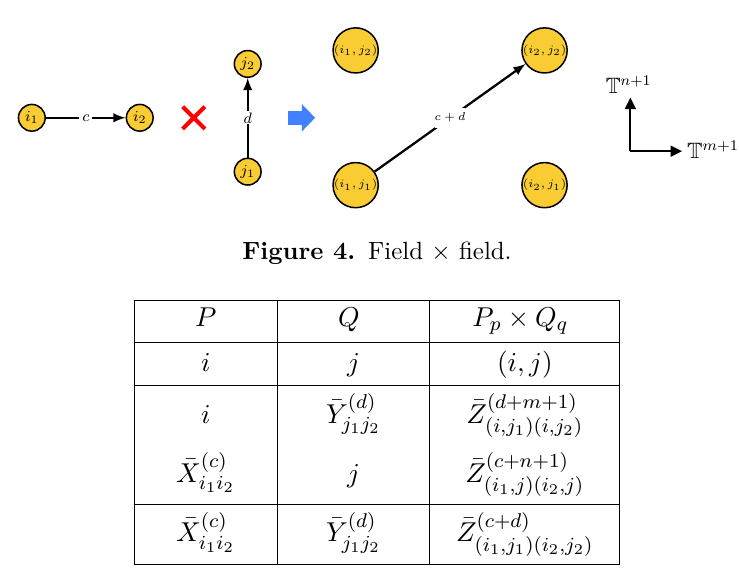
Table 1. Summary of the construction of the periodic quiver for P p × Q q .